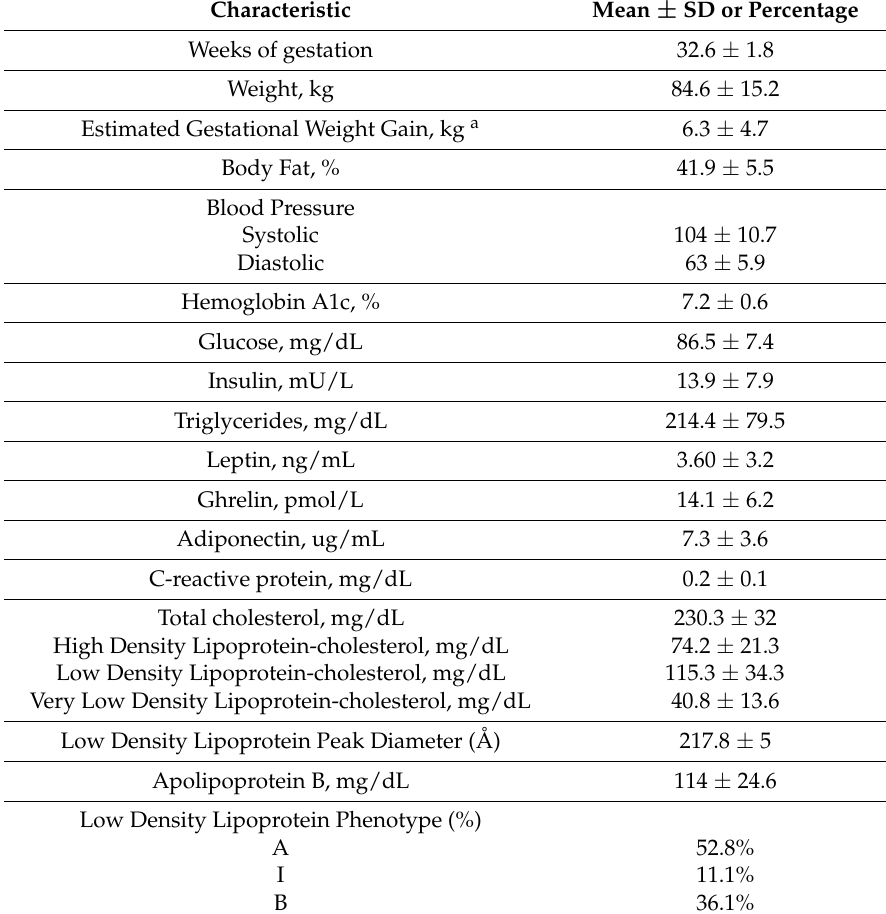
Table 3. Participant